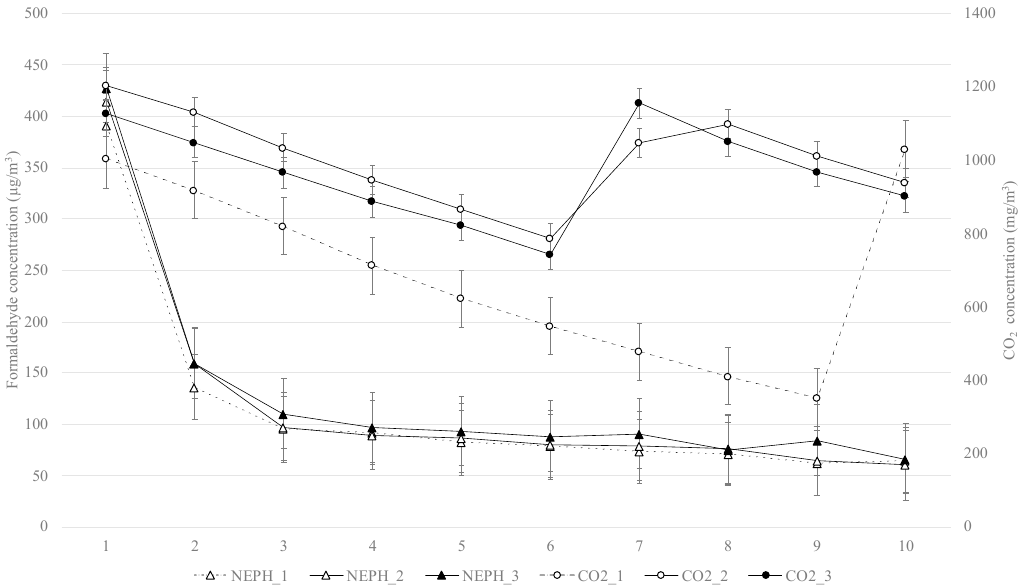
Figure 9. Depletion of formaldehyde (NEPH_1, NEPH_2, and NEPH_3) vs. depletion of CO 2 (CO2_1, CO2_2, and CO2_3): for the three Boston ferns. Data means ± SE, n = 3.